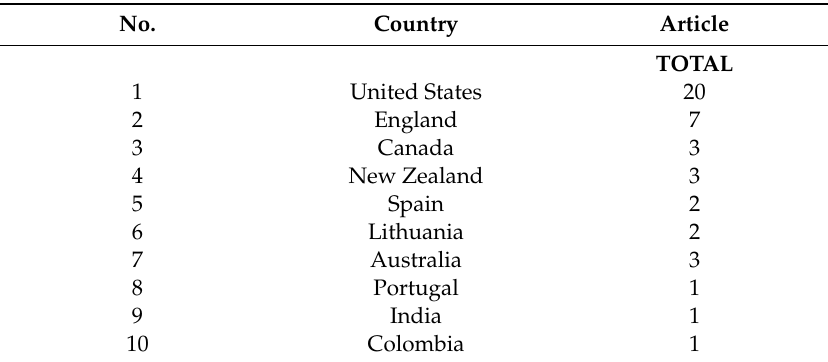
Table 4. Top 10 most productive